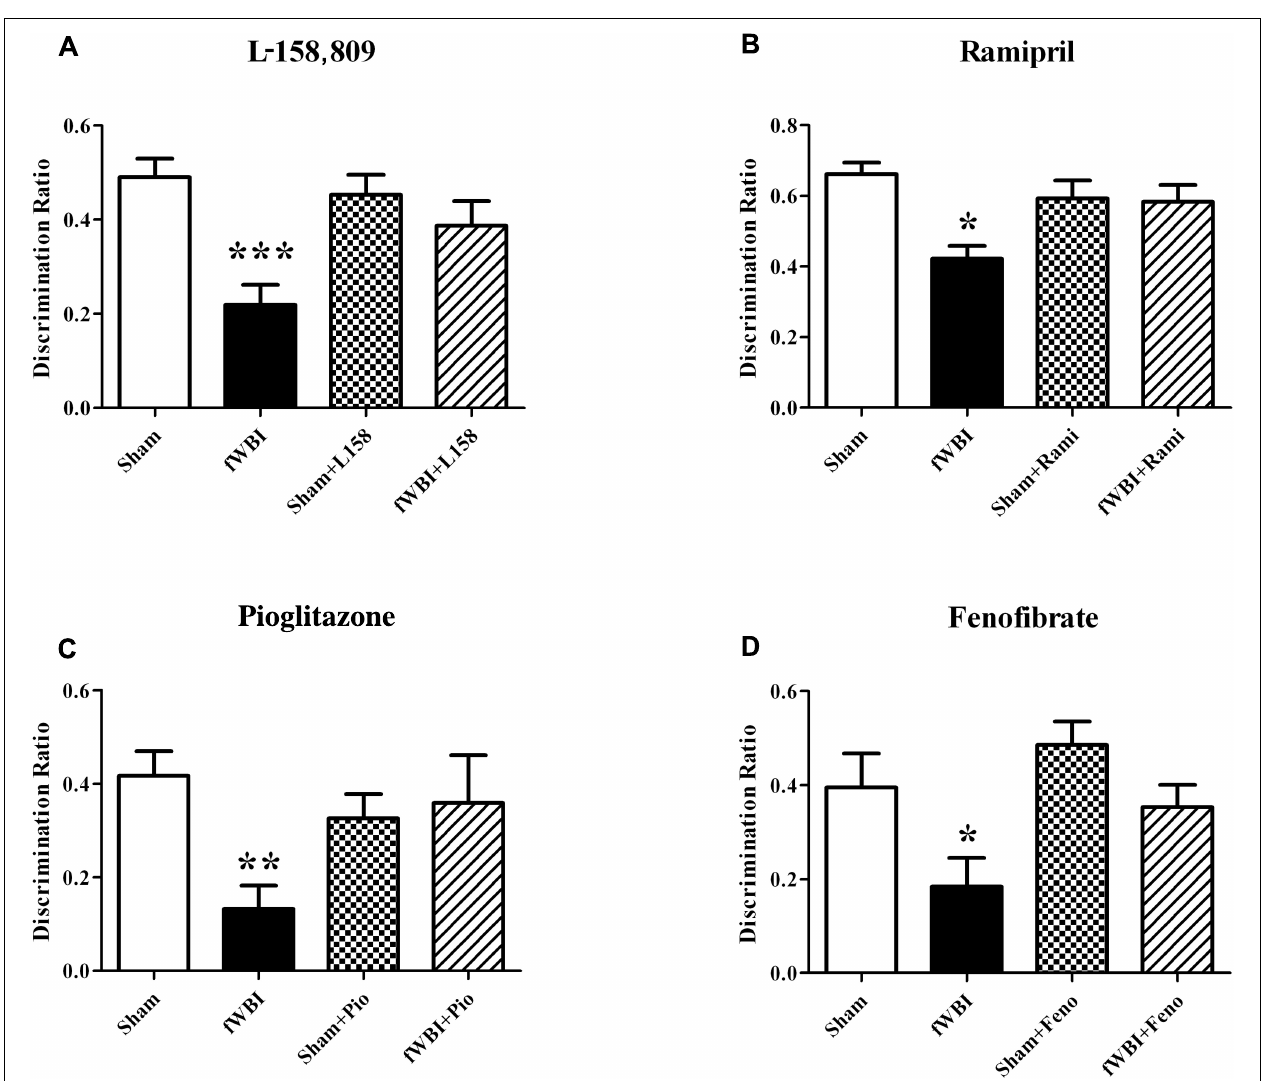
(B) the ACEI, ramipril, before, during, and for 28 weeks post-fWBI; tested at 26 weeks, (C) the PPAR γ agonist, pioglitazone, before, during, and for 54 weeks post-fWBI; tested at 52 weeks, and (D) the PPAR α agonist, fenofibrate, before, during, and for 29 weeks post-fWBI; tested at 26 weeks. * P < 0.05, ** P < 0.01, *** P < 0.001 compared to sham- irradiated